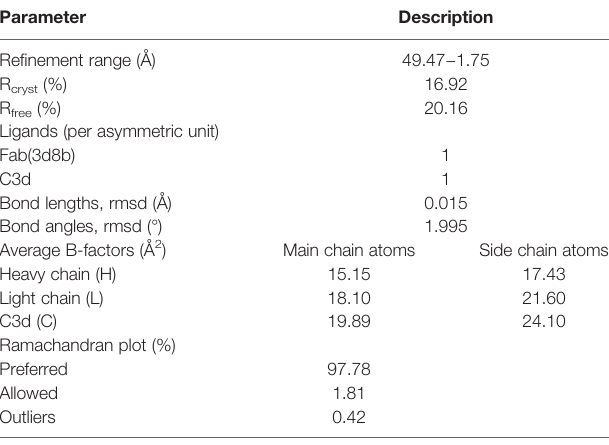
TABLE 1 | Model re fi nement statistics for Fab(3d8b):C3d complex (PDB ID 7UE9). Parameter